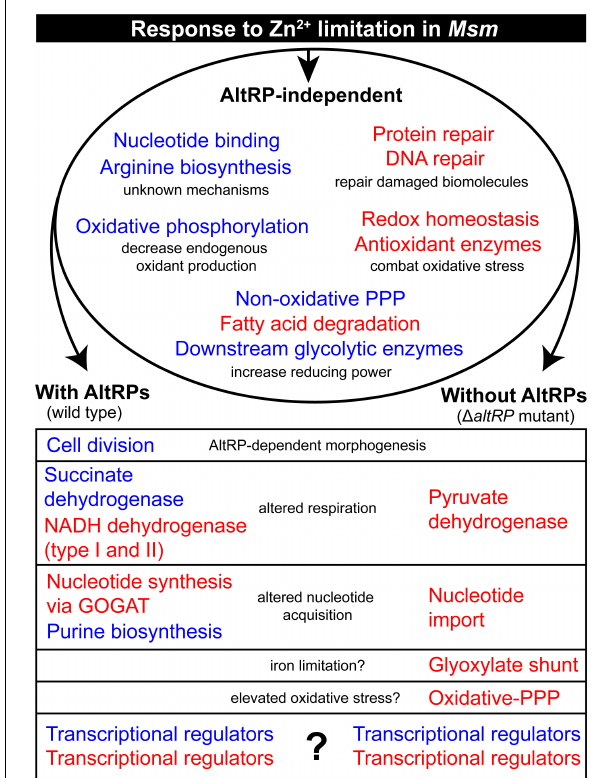
FIGURE 5 | Summary of the molecular response to Zn 2 + -limitation in Msm , including AltRP-specific effects. The model shows the shared and unique physiological response of the wild type and the (cid:49) altRP mutant grown under Zn 2 + -limiting conditions when compared to the Zn 2 + -replete wild type. The multi-omics data was simplified into general biological processes which are colored in red and blue to indicate up-regulation and down-regulation of process during Zn 2 + limitation, respectively. The descriptors in black give the presumed reason for the differential regulation of the process in the Zn 2 + -limited environment, or the relevance of the differences between the wild type and (cid:49) altRP mutant.